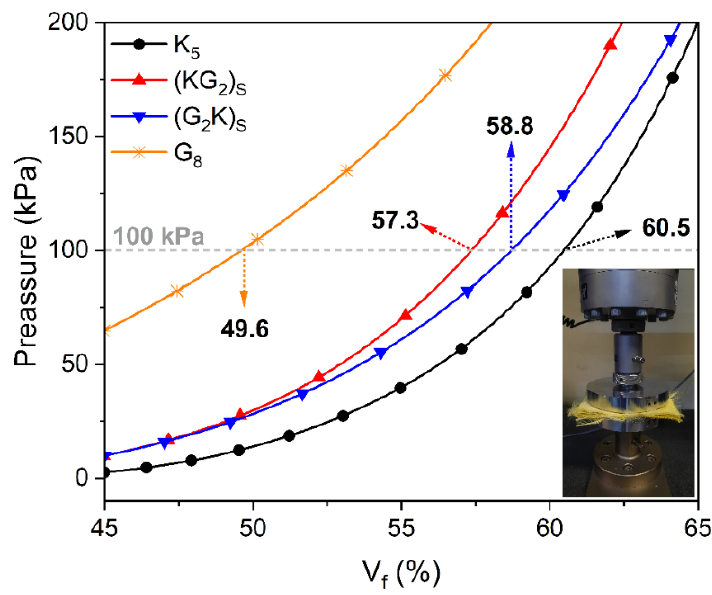
Figure 3. Compression test results for the K 5 , (KG 2 ) S , (G 2 K) S and G 8 fabric stackings.